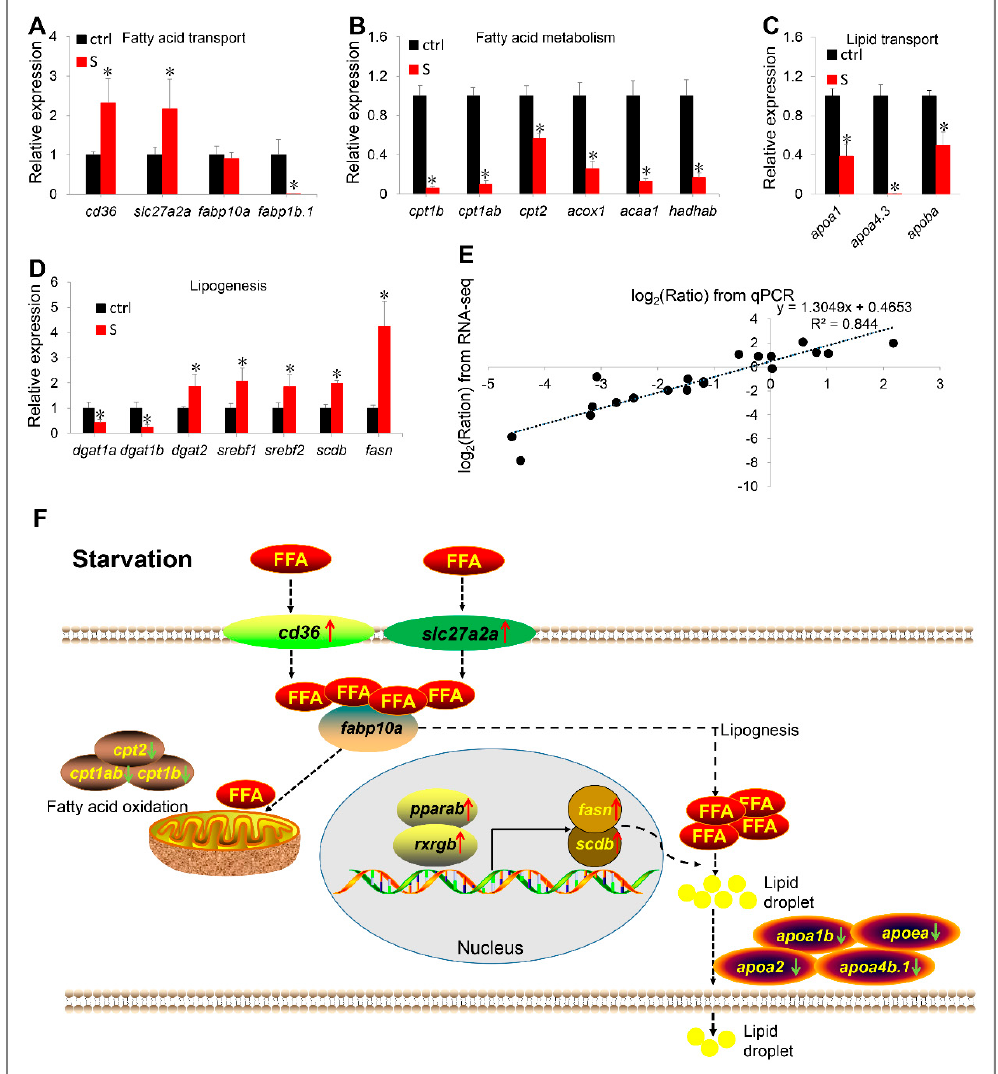
Figure 8. ( A–E ) Validation of RNA-seq data by qPCR. The mRNA levels of 20 genes involved in fatty acid transport ( A ), fatty acid metabolism ( B ), lipid transport ( C ), and lipogenesis ( D ) were measured by qPCR. ( E ) Correlation analysis of gene expression between RNA and qPCR. Scatter plot of gene expression in RNA-seq (y-axis) and qPCR (x-axis). “Ratio” in log 2 (Ratio) represents the fold change with gene expression. * indicates significant differences ( p < 0.05). ( F ) Schematic diagram of starvation triggering hepatic steatosis by regulating liver fatty acid intake, β oxidation, de novo lipogenesis and lipid transport. Starvation up-regulated transcription of slc27a2a , slc27a6-like , and cd36 , promoting extrahepatic fatty acid uptake. In liver, starvation induces the expression of lipogenesis-related genes ( srebf1 , srebf2 , fasn , and scdb ) by activating the PPAR α /RXR pathway, thereby promoting lipogenesis. Meanwhile, the fatty acid metabolism pathway was inhibited. Thus, most ingested extrahepatic fatty acids are used for lipogenesis rather than β oxidation. However, synthetic fat appears to be blocked in the liver, because starvation inhibits the expression of numerous apolipoprotein genes. Red arrows indicate up-regulated genes, green arrows indicate down-regulated genes. FFA: free fatty acid.